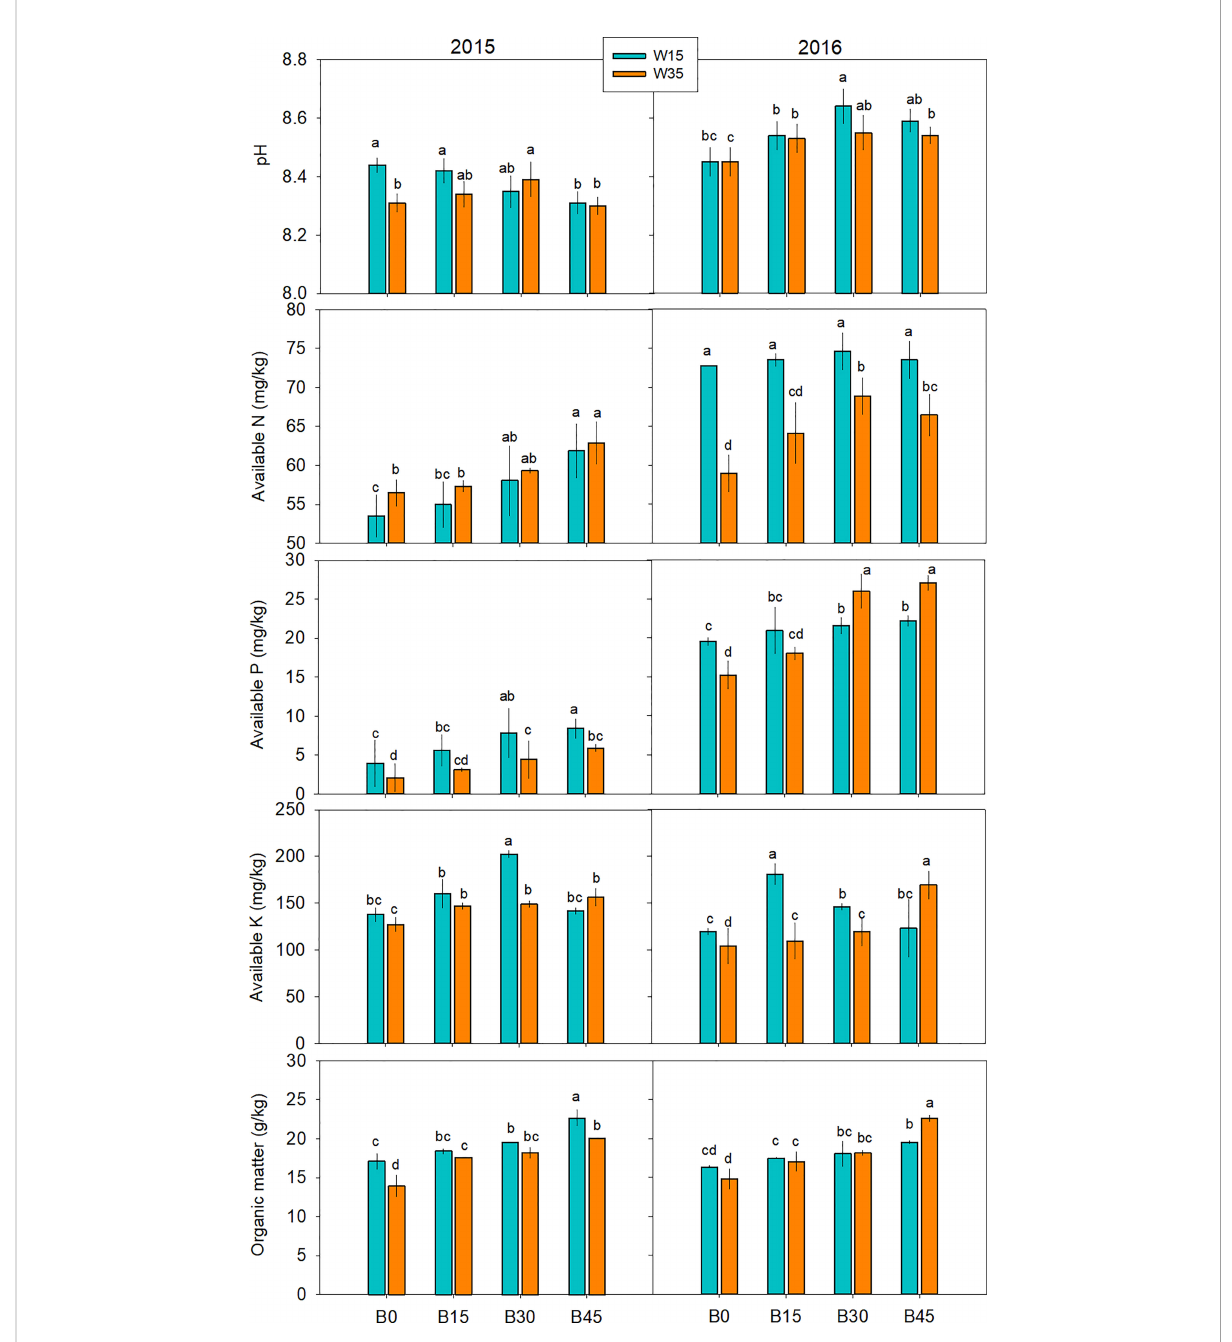
FIGURE 4 Soil pH, available nutrients, and organic matter at top 15-cm layer during maize physiological maturity stage under biochar amendments (B0, B15, B30, and B45, referring as 0, 15, 30, and 45 t ha -1 ) and irrigation water lower limits at soil matric potential -15 (W15) and -35 kPa (W35). Different lowercase represents signi fi cant difference at P<0.05 between